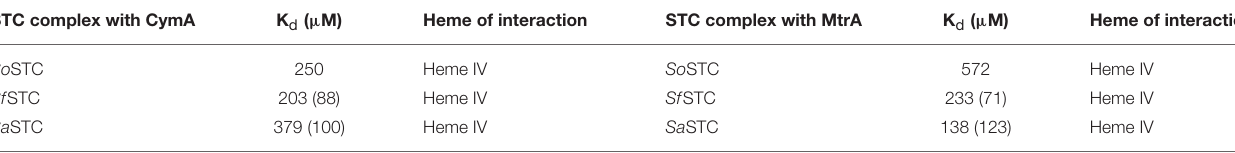
TABLE 4 | Pairwise interactions tested for So STC (Fonseca et al., 2013), Sa STC and Sf STC (this work) with So MtrA and So CymA. STC complex with CymA